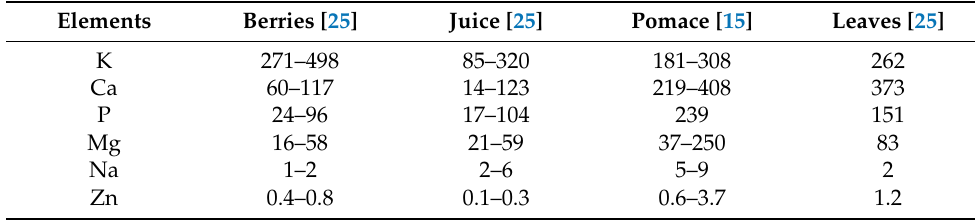
Table 3. Macro- and micro-element contents (mg/100 g) in Aronia melanocarpa berries, juice, pomace and